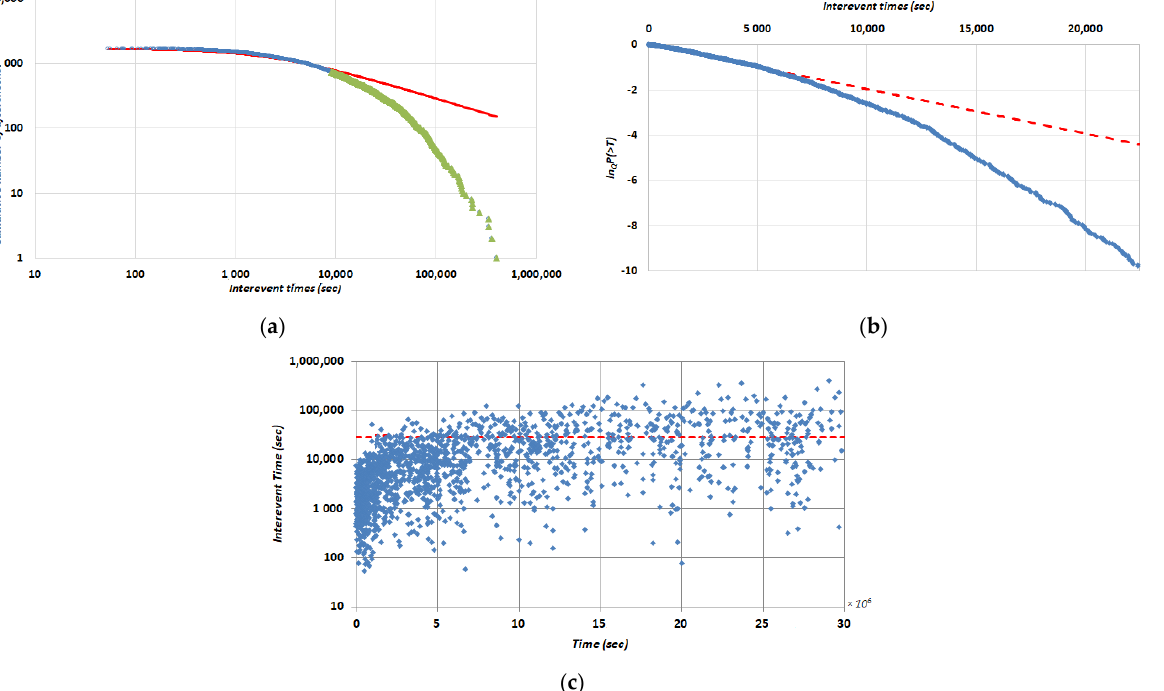
Figure 7. ( a ) The interevent times CDF of the 2018 M w 6.6 Zakynthos Earthquake, for the events with M > M c . The scarlet stroke is the Q -exponential fitting with q = 1.68. The change of colors indicates the crossover between the NESP (blue circles) and BG statistics (green triangles). ( b ) The ln Q P (> T ) as a function of T , where the red line is the fitting with q = 1.68 and correlation coefficient 0.9966 up to T c . T c value close to 5607 s is suggested by the deviation from linearity. ( c ) Interevent time T evolution with time t since the main shock. The scarlet line illustrates the T c value.